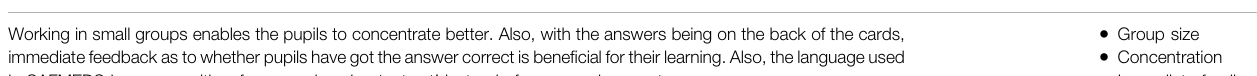
TABLE 3 | An example data extract from the online survey and the corresponding codes. Data extract Coded for Working in small groups enables the pupils to concentrate better. Also, with the answers being on the back of the cards, immediatefeedbackastowhether pupilshavegottheanswercorrectisbene fi cialfortheirlearning.Also,thelanguageused in SAFMEDS is more positive, for example using ‘ not yet ’ instead of wrong or